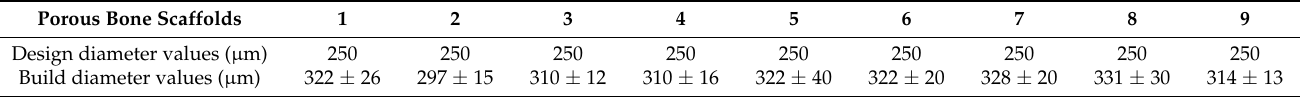
Table 5. Design dimensions and actual dimensions of the FCC structure.